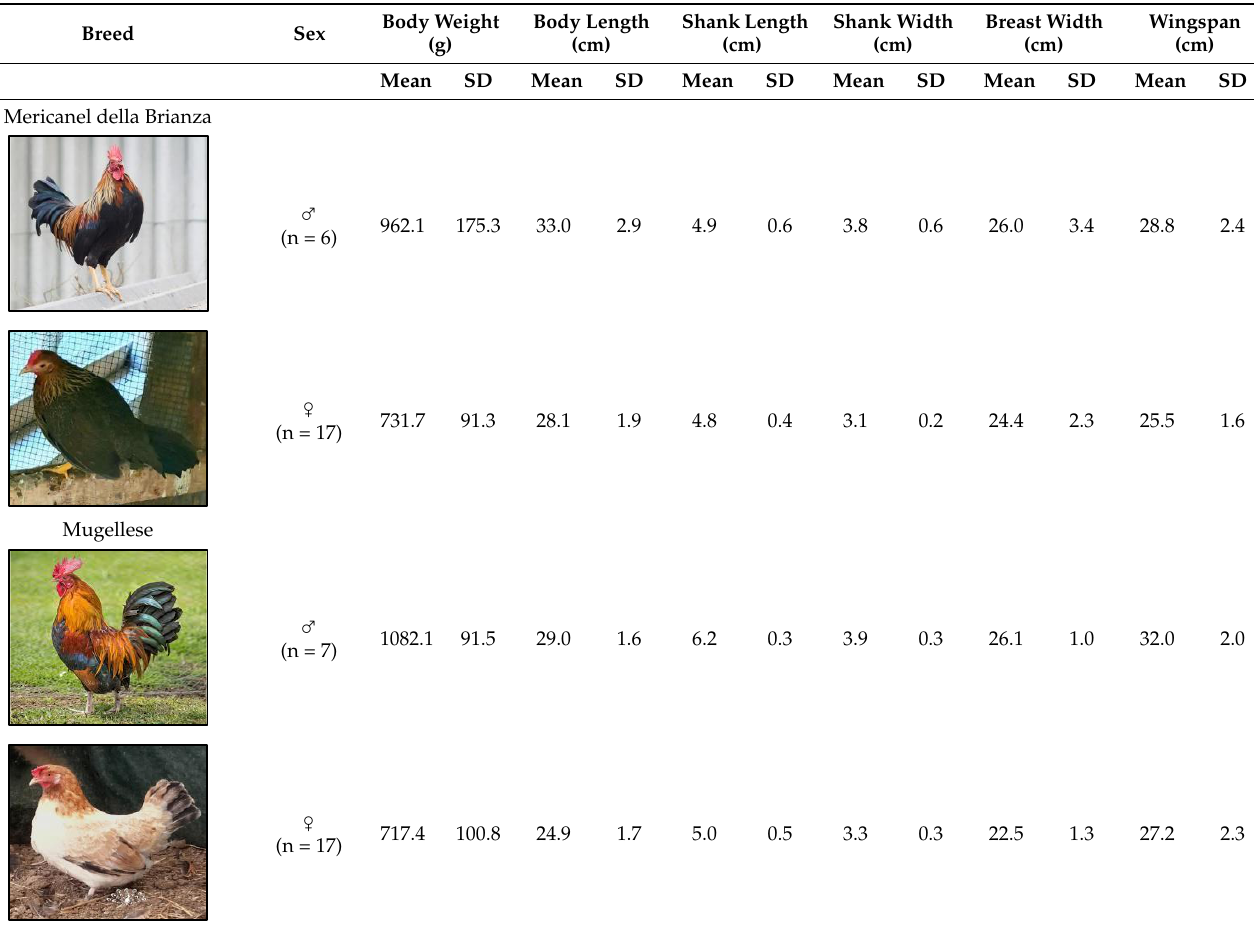
Table 1. Mean and standard deviation (SD) of the morphometric traits of Mericanel della Brianza, Mugellese, and Pepoi local chicken breeds (presumed dwarf), and the local heavy breeds used as the control population, namely, Ermellinata di Rovigo, Robusta Lionata, and Robusta Maculata (Broiler Ross 708 is not reported in the table as phenotypic characterization was conducted only for local breeds).